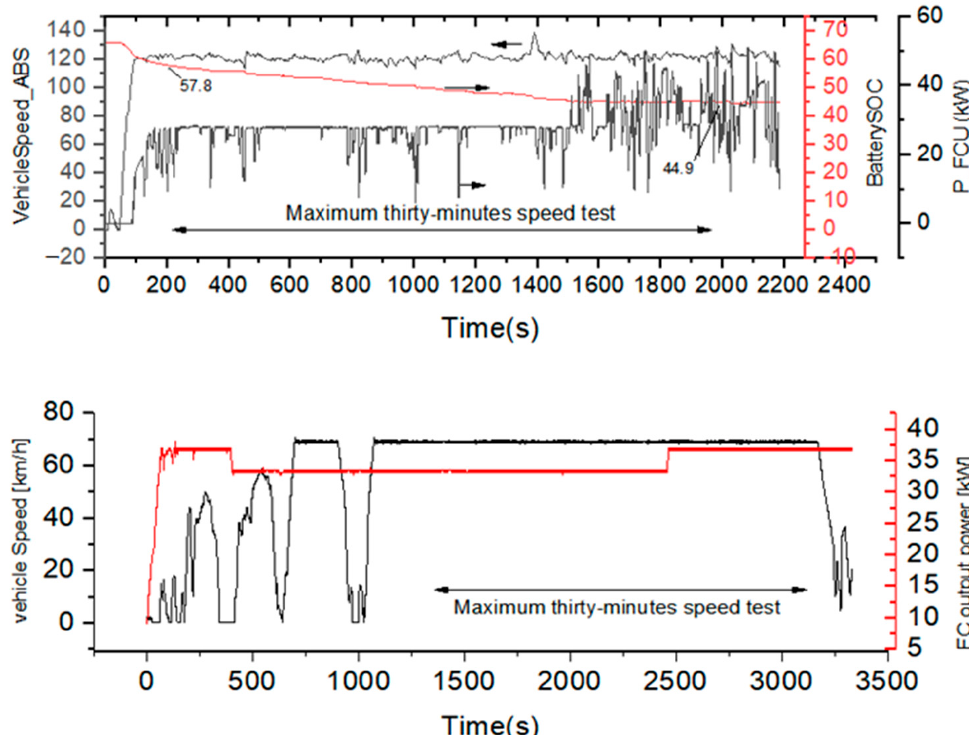
Figure 13. Comparison of maximum thirty-min speed test.